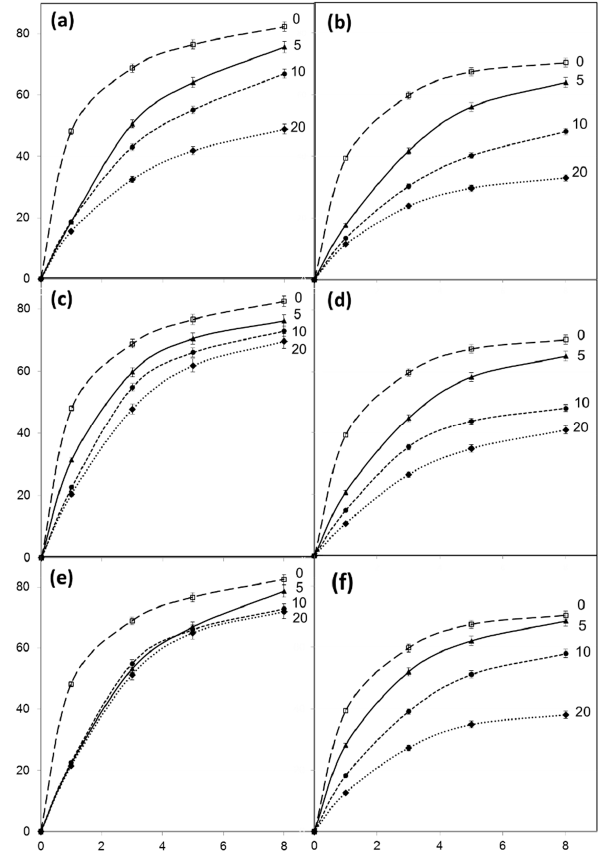
Figure 2. Cumulative recoveries as a function of flotation time and organic matter concentration (mg/L) for chalcopyrite with HA ( a ), TA ( c ), and FA ( e ) and for molybdenite with HA ( b ), TA ( d ) and FA ( f ) (pH = 9.3).